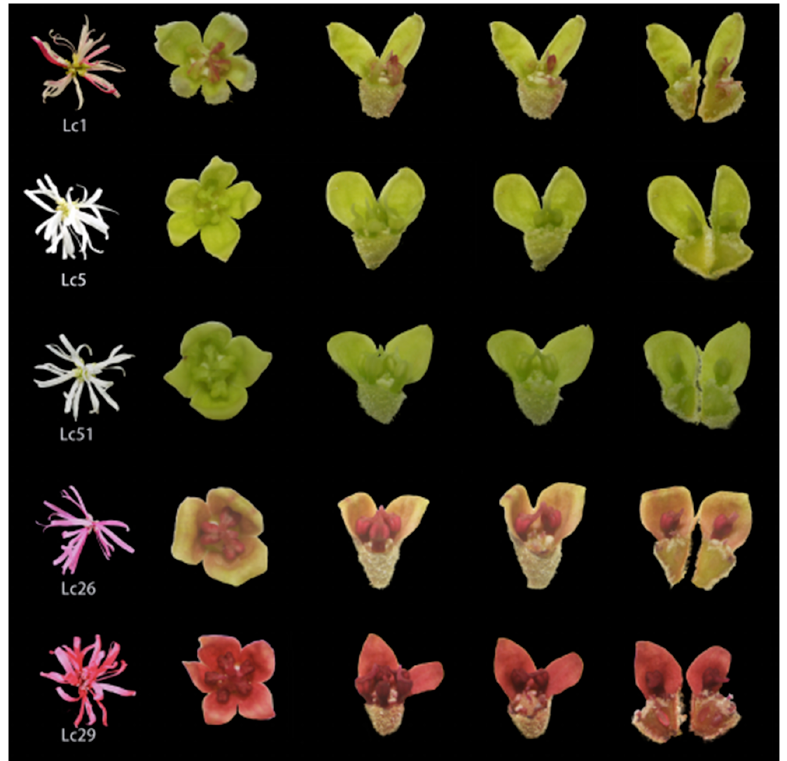
Figure 6. Analysis of calyx and nectary of different color groups of L. chinense var. rubrum. Note: Lc1 represents the polychromatic group; Lc5 represents the yellowish white group; Lc51 represents the green - white group; Lc26 represents the purplish pink group; Lc29 represents the purplish red group.